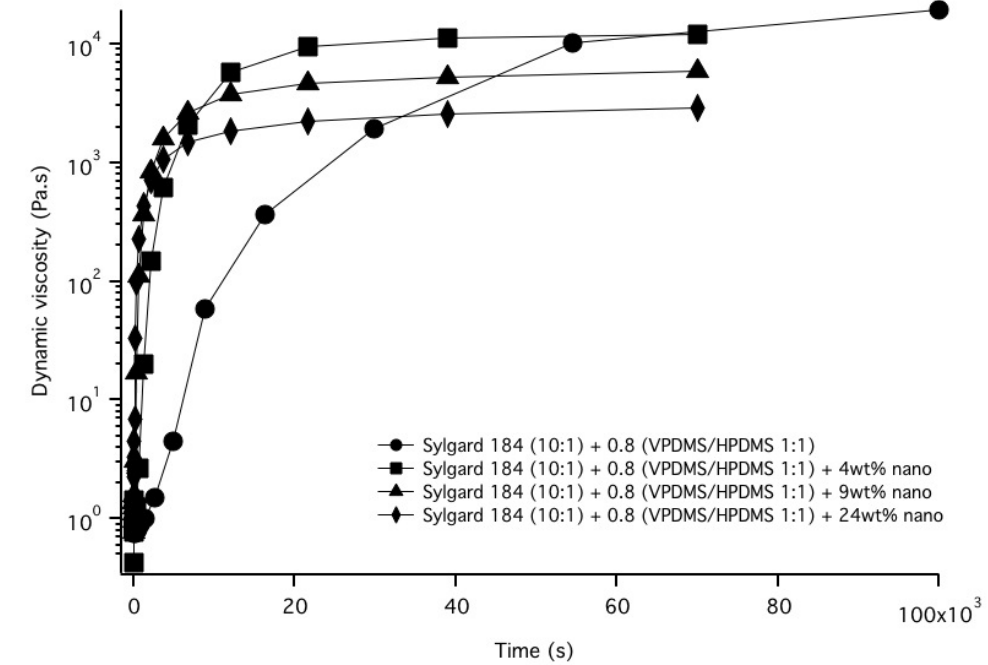
Figure 5. Dynamic viscosity versus time for Sylgard 184 with (HPDMS:VPDMS) (mixture ratio 1:0.8) reticulation without and with 4 wt%, 9 wt%, and 24 wt% of